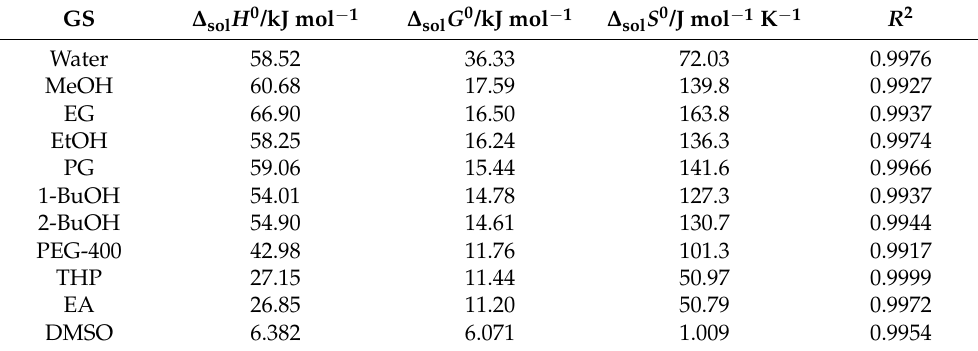
Table 7. Apparent thermodynamic parameters ( ∆ sol H 0 , ∆ sol G 0 , and ∆ sol S 0 ) along with R 2 values for ITN in eleven distinct green solvents b